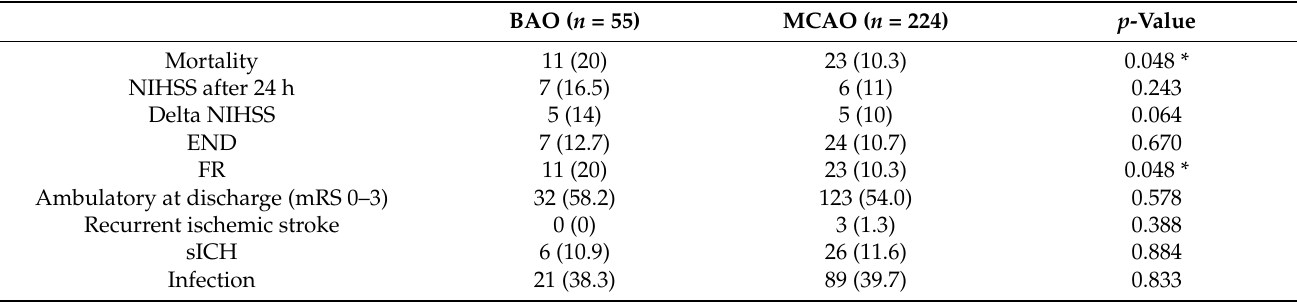
Table 3. Outcomes and complications in BAO and MCAO groups.